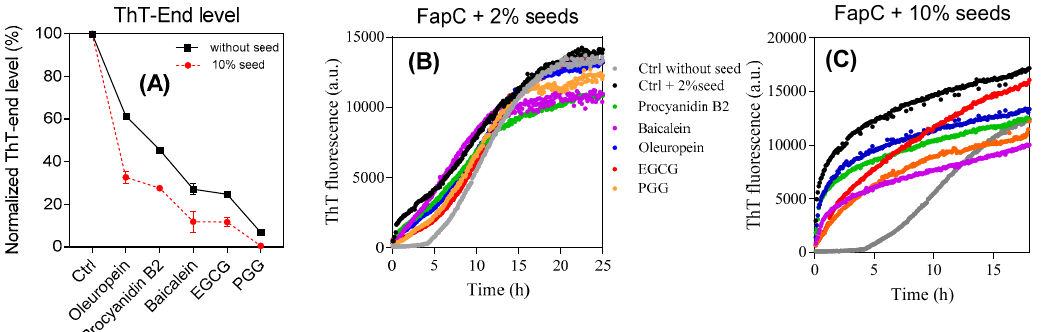
Figure 3. Seeding experiments to test the ability of different aggregates to promote fibrillation of monomeric FapC- UK4 . ( A ) Seeds: FapC fibrils. Solution: Monomeric FapC (30 µM) together with polyphenols (120 µM); ( B ) and ( C ) seeds: Aggregates of FapC formed in the presence of 2% and 10% ( v / v ) polyphenols and spun down. Solution: Monomeric FapC (30 µM). The indicated labelling scheme applies to both (B) and (C).